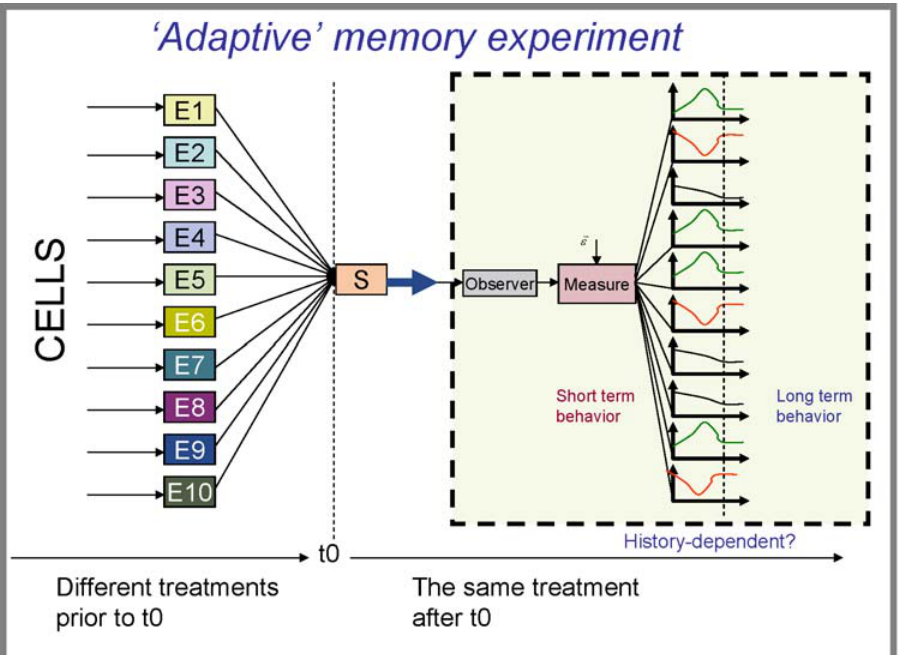
Figure 2. An ‘adaptive’ memory experiment. In an adaptive memory experiment, each (identical) sample of a biological system is subjected to one of several conditions prior to time t0, and then observed in a common condition after t0. If different past histories lead to different short-term behaviors in current conditions, the system can be said to exhibit short-term memory. If different past histories lead to different long-term behaviors, the system can be said to exhibit long-term